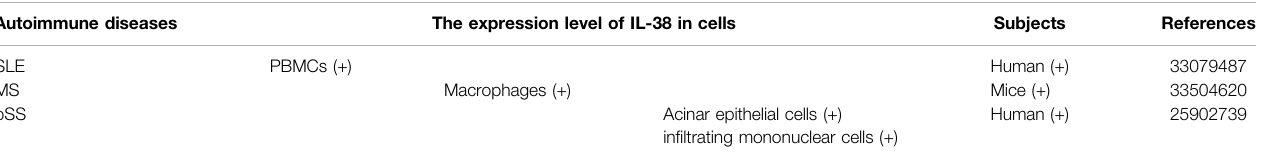
TABLE 3 | The expression level of IL-38 in cells of autoimmune diseases. Autoimmune diseases The expression level of IL-38 in cells